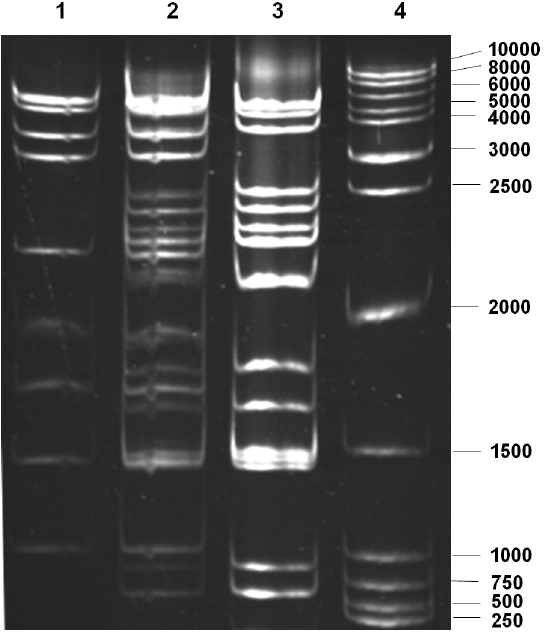
Figure 1. Electrophoretic analysis of DpCPV-MC before and after the in vivo cloning procedure. Electrophoresis was performed in 1 6 TAE (40 mM Tris–acetate, 1 mM EDTA, pH 7.8) at a constant voltage of 50 V for 4 h on a 13% polyacrylamide gel stained with ethidium bromide. Lane 1: DpCPV-1; lane 2: CPV mixture originally collected from D. punctatus ; lane 3: DpCPV-MC; lane 4: 1-kb DNA ladder (Promega).